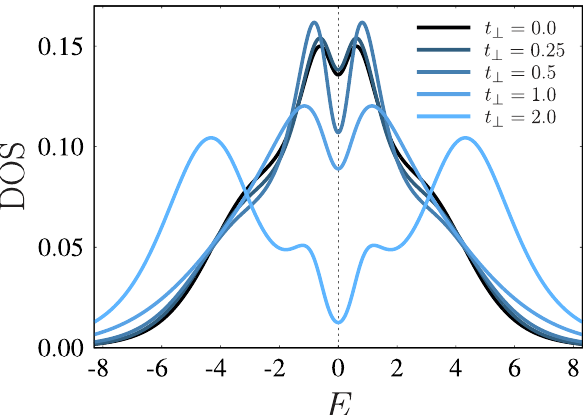
Figure 10: DOS for a bilayer square lattice obtained at t = 1, U = 4, β = 4 for dif- ferent values of the interlayer hopping t ⊥ . Lighter shades of blue indicate larger t ⊥